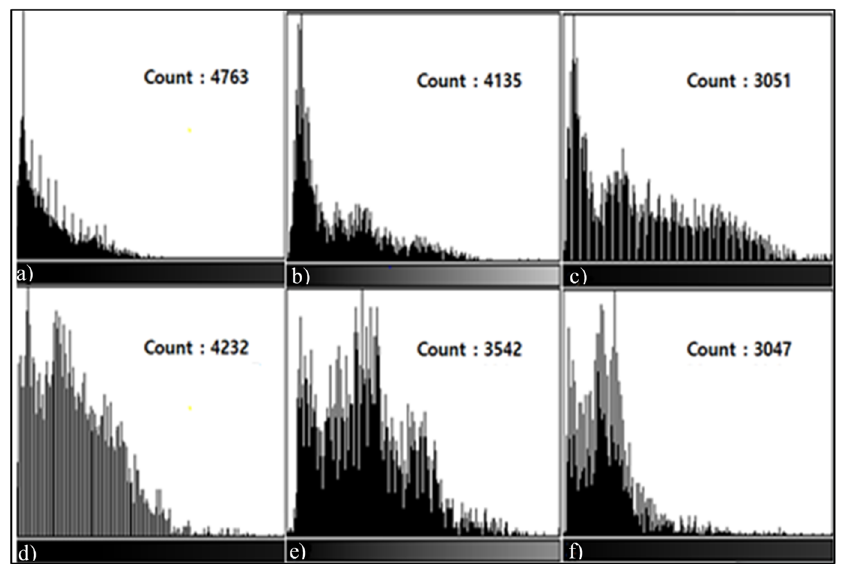
Figure 5. L4, L5 Histogram values measured in the T2 Sagittal Images of transplant patients. In the L4, L5 T2 Sagittal Images, as the same result as that for the Pig L-spine Phantom, the T2 CS-SEMAC (SPIR) technique shows higher values. T2 STIR Histogram ( a ); mDixon (O-MAR) Histogram ( b ); T2 CS-SEMAC (SPIR) Histogram ( c ); and T2 STIR Histogram measured in L5 ( d ); T2 mDixon (O-MAR) Histogram ( e ); and T2 CS-SEMAC (SPIR) Histogram ( f ).